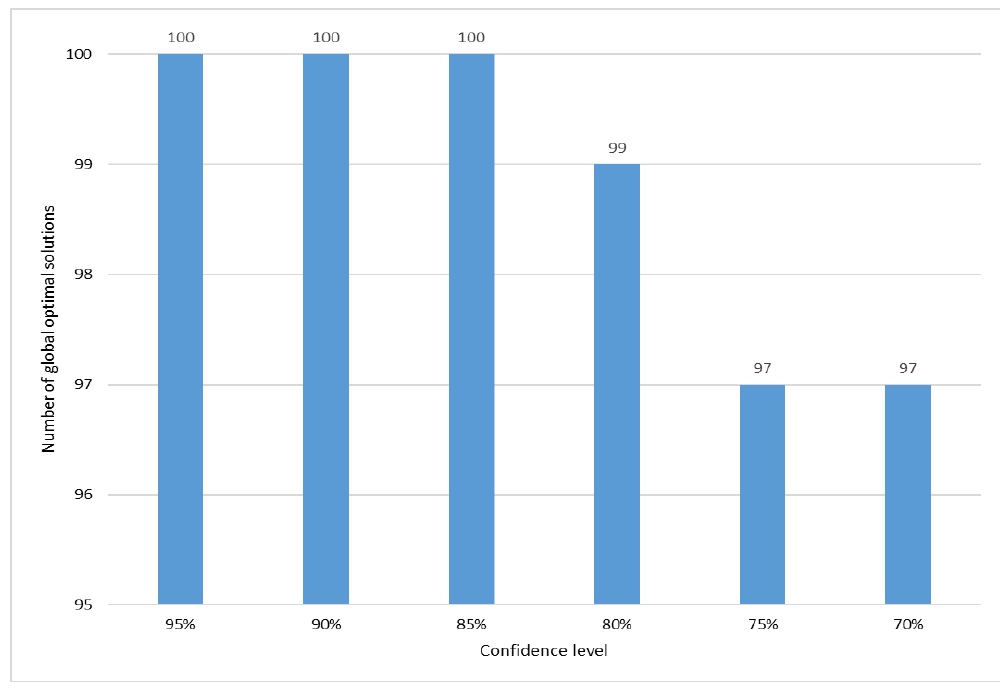
Figure 3. The number of global optimal solutions under different confidence levels in a random sample.